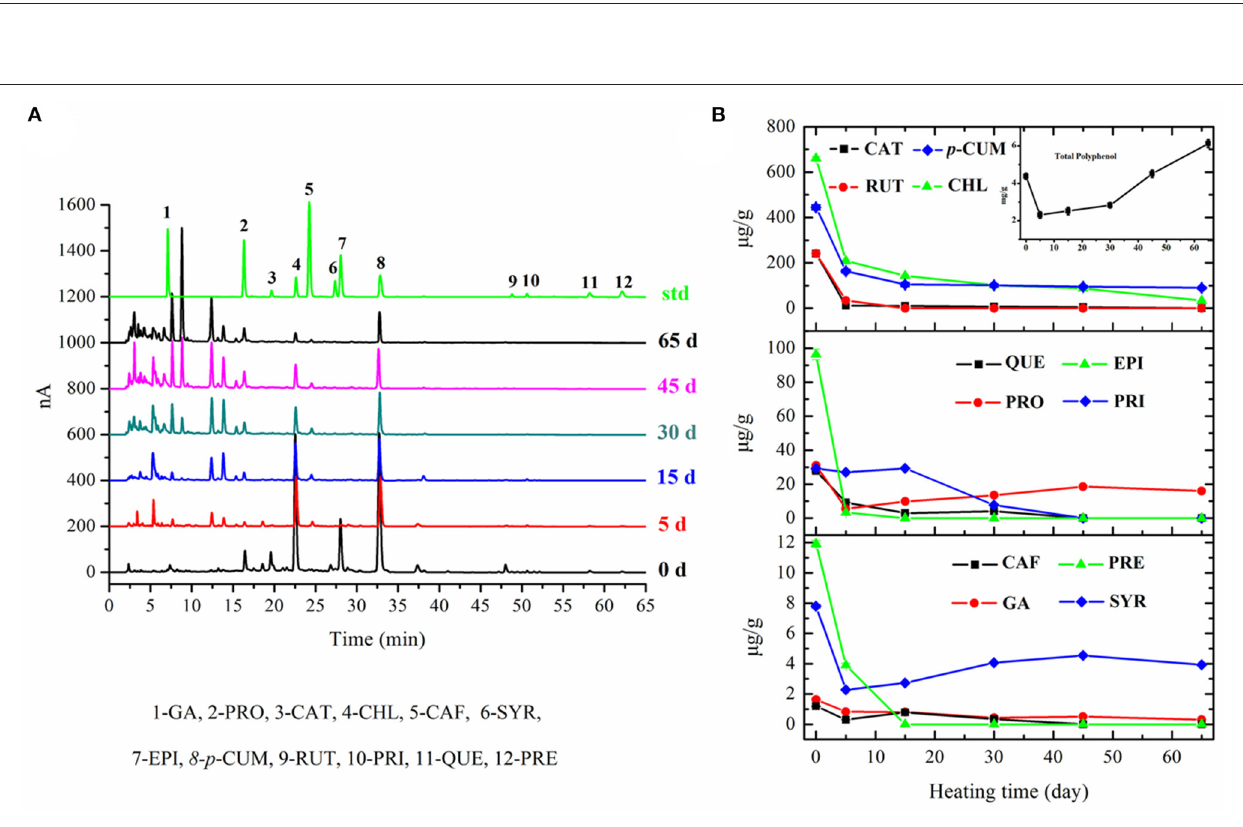
Frontiers in Nutrition |